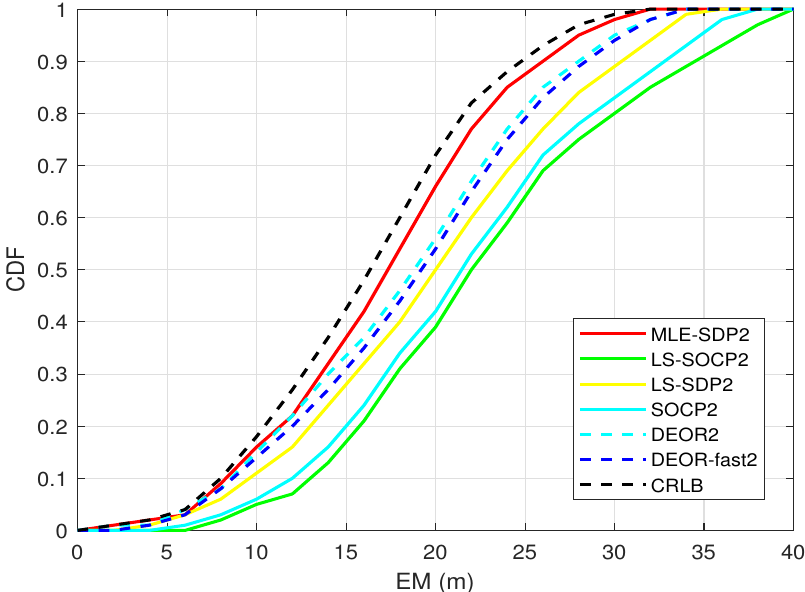
Figure 7. When L 0 is unknown, this is the CDF.